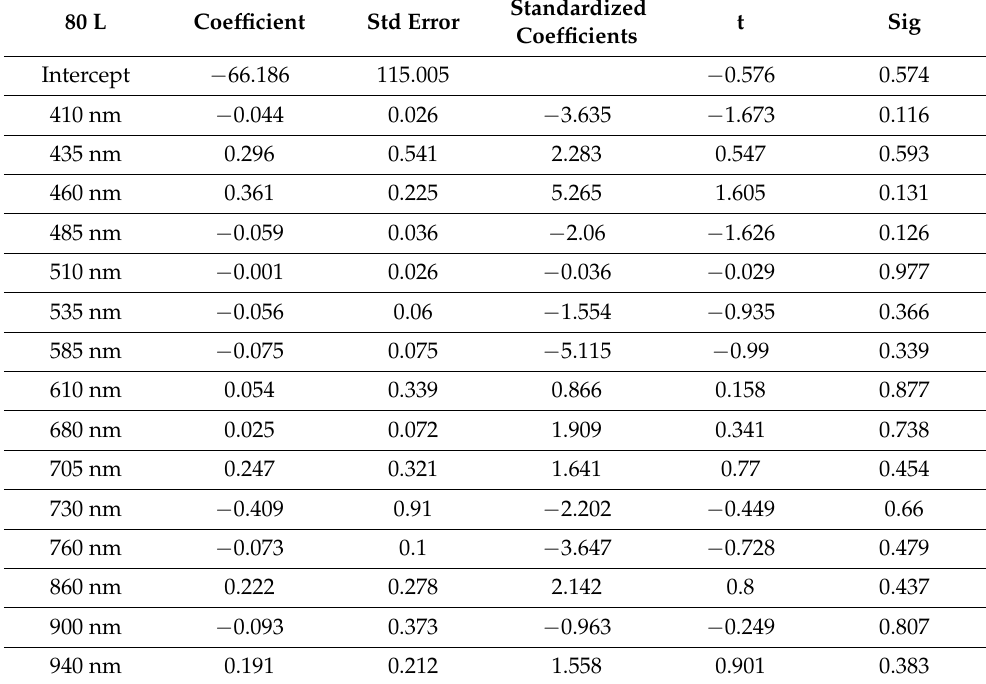
Table 7. Tank L MLR coefficients. Three wavelengths (560 nm, 645 nm, and 810 nm) were excluded from the model due to high